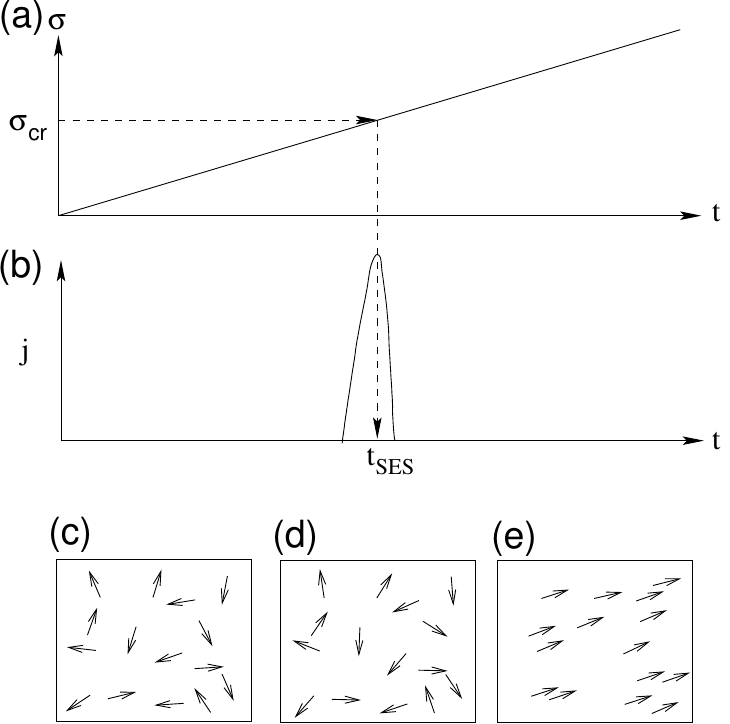
Figure 1. The physical model for SES generation since the 1980s. ( a ) The stress σ gradually increases in the focal area before an EQ versus the time t towards reaching a critical value σ cr . ( b ) When σ reaches σ cr a transient electric signal is generated. This is an SES. ( c ) Random orientation of the electric dipoles at small stress. ( d ) Partial orientation at an intermediate stress σ ( < σ cr ) . ( e ) Cooperative orientation of the electric dipoles when σ = σ cr